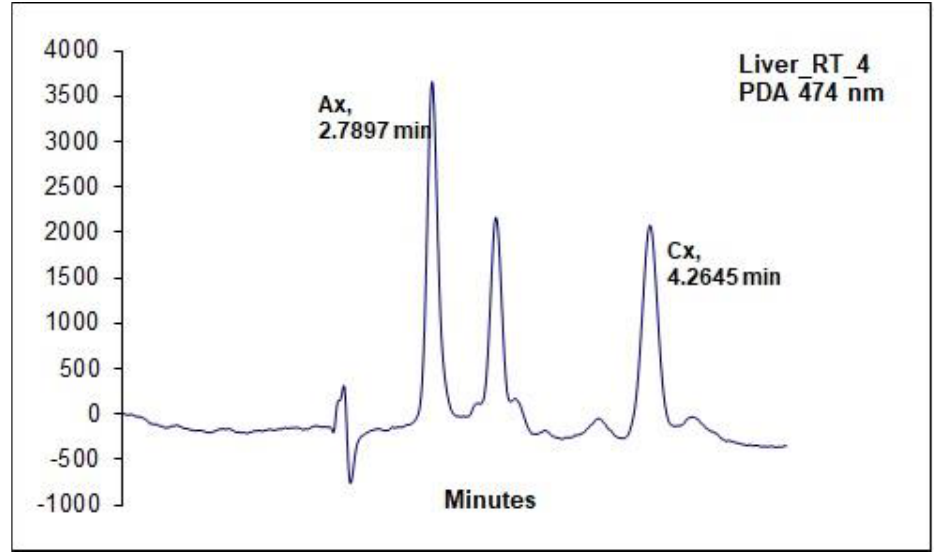
Figure 4. Typical chromatogram of sample solution of liver.